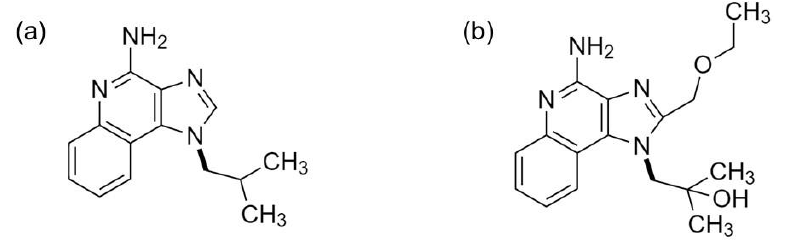
Figure 4. Chemical structures of ( a ) IMQ, and ( b ) RSQ.